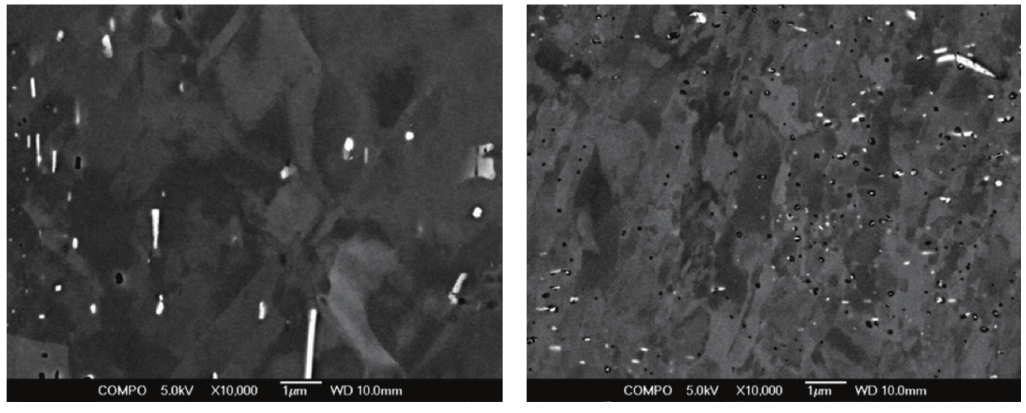
Figure 8: SEM micrographs at 10000x of the blades forged at 25 ∘ C.